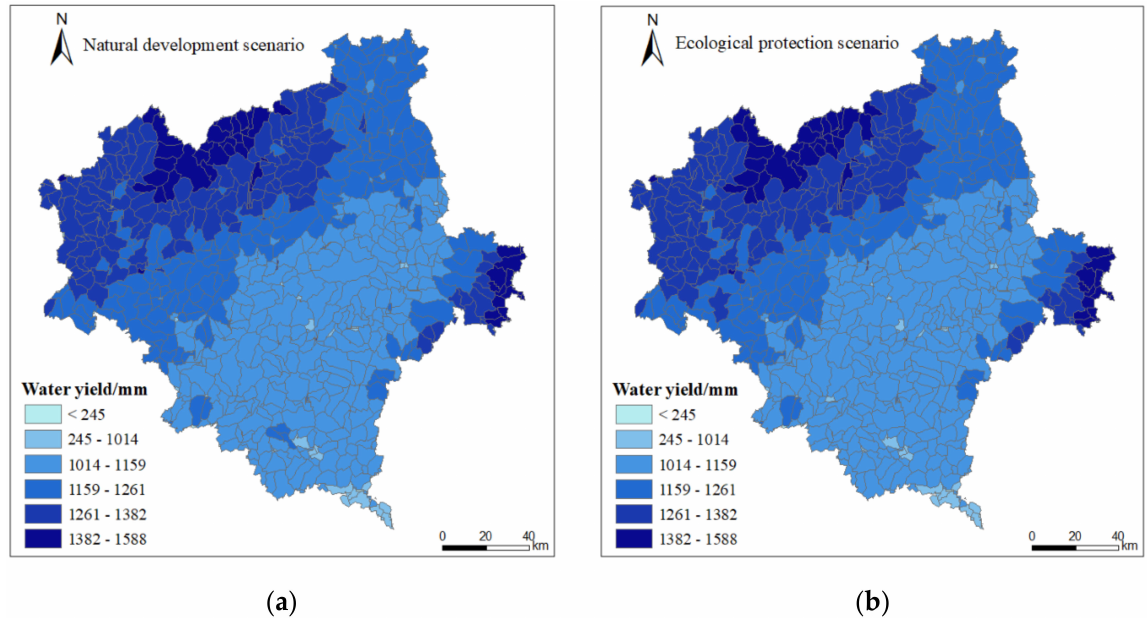
Figure 6. Spatial distribution of water yield in 2025 under ( a ) the natural development scenario and ( b ) the ecological protection